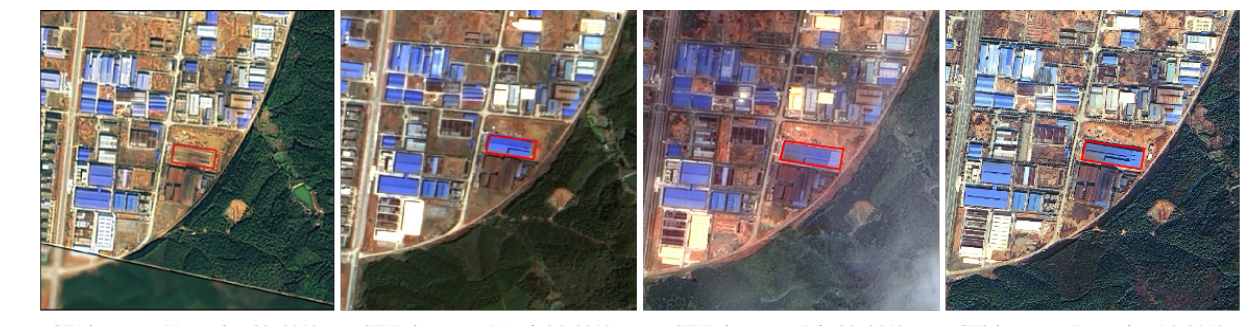
Figure 4. Parcel 03, 05 and 06 in Yangtze Alligator Nature Reserve